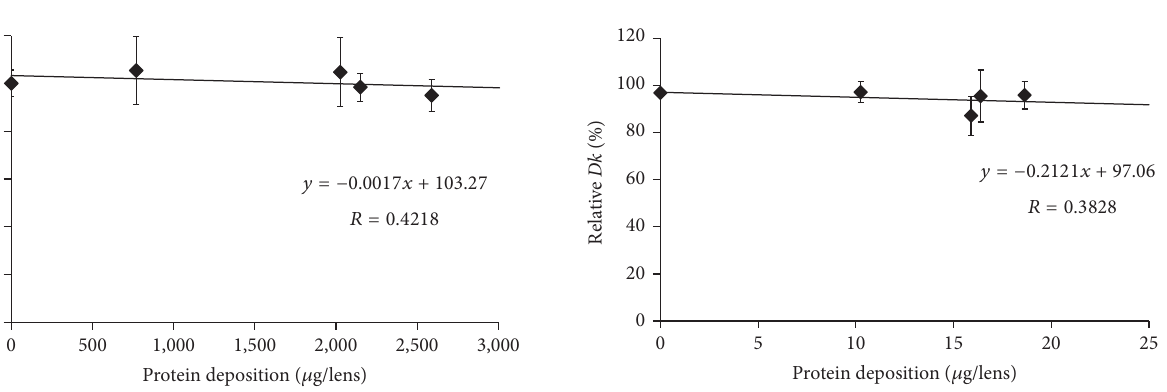
Figure 2: Relationship between relative Dk and amount of protein deposition on nelfilcon A lens.